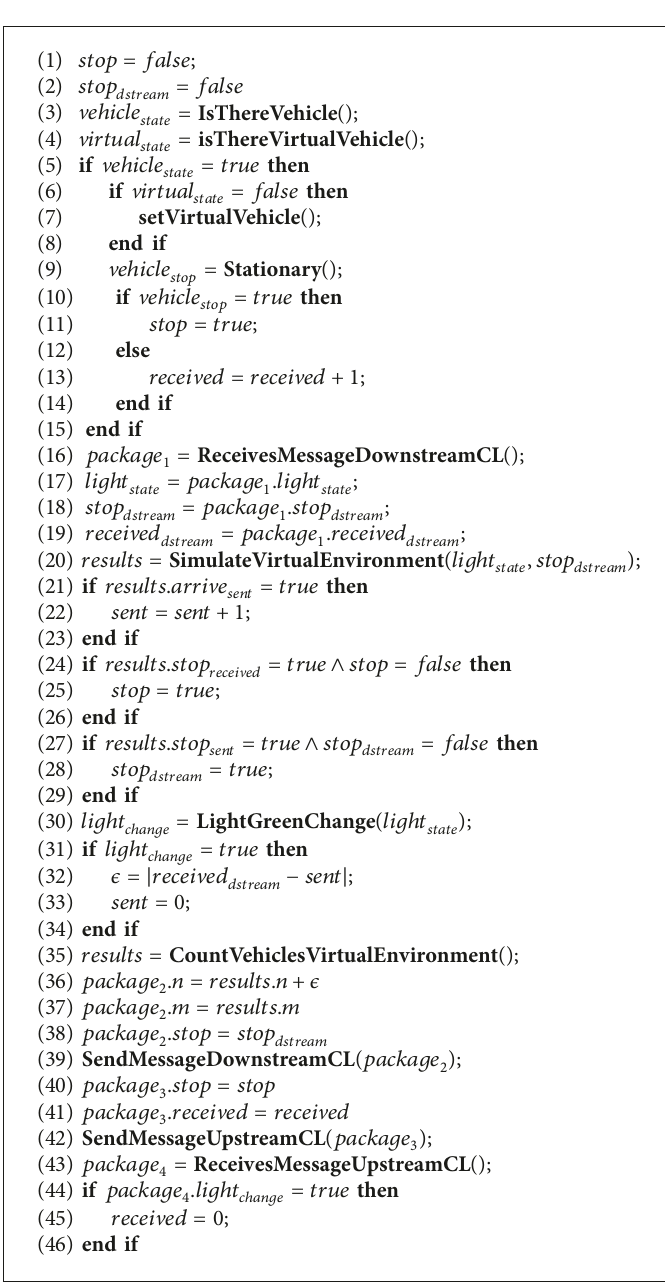
Algorithm 1: Deliberative sensors